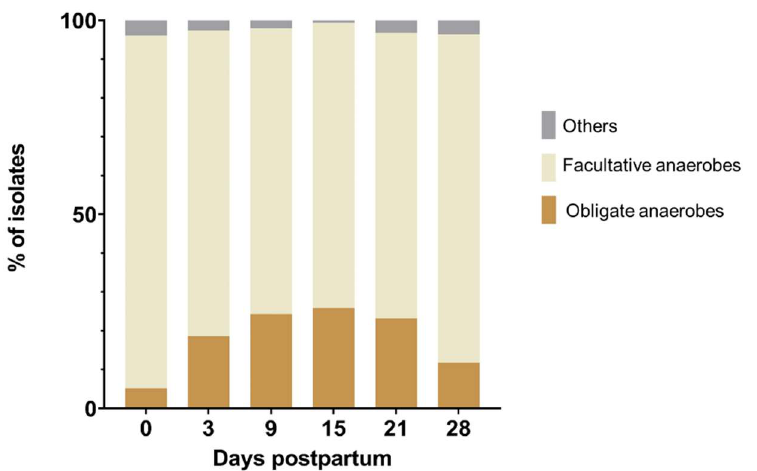
Figure 1. Relative abundance of obligate anaerobes, facultative anaerobes, and other bacteria (mi- croaerophiles and probable new species without known metabolism) at the day of calving (day 0) and on days 3, 9, 15, 21, and 28 postpartum.